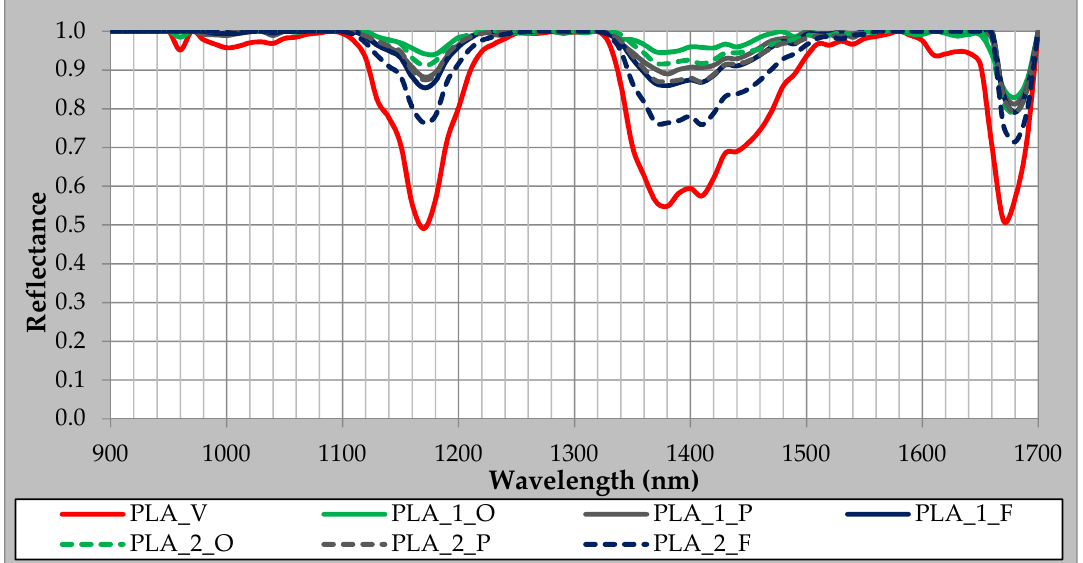
Figure 7. Spectral signatures of PLA samples in the NIR region, detected with linear spectrometer, processed with the method Continuum Removal (CR).